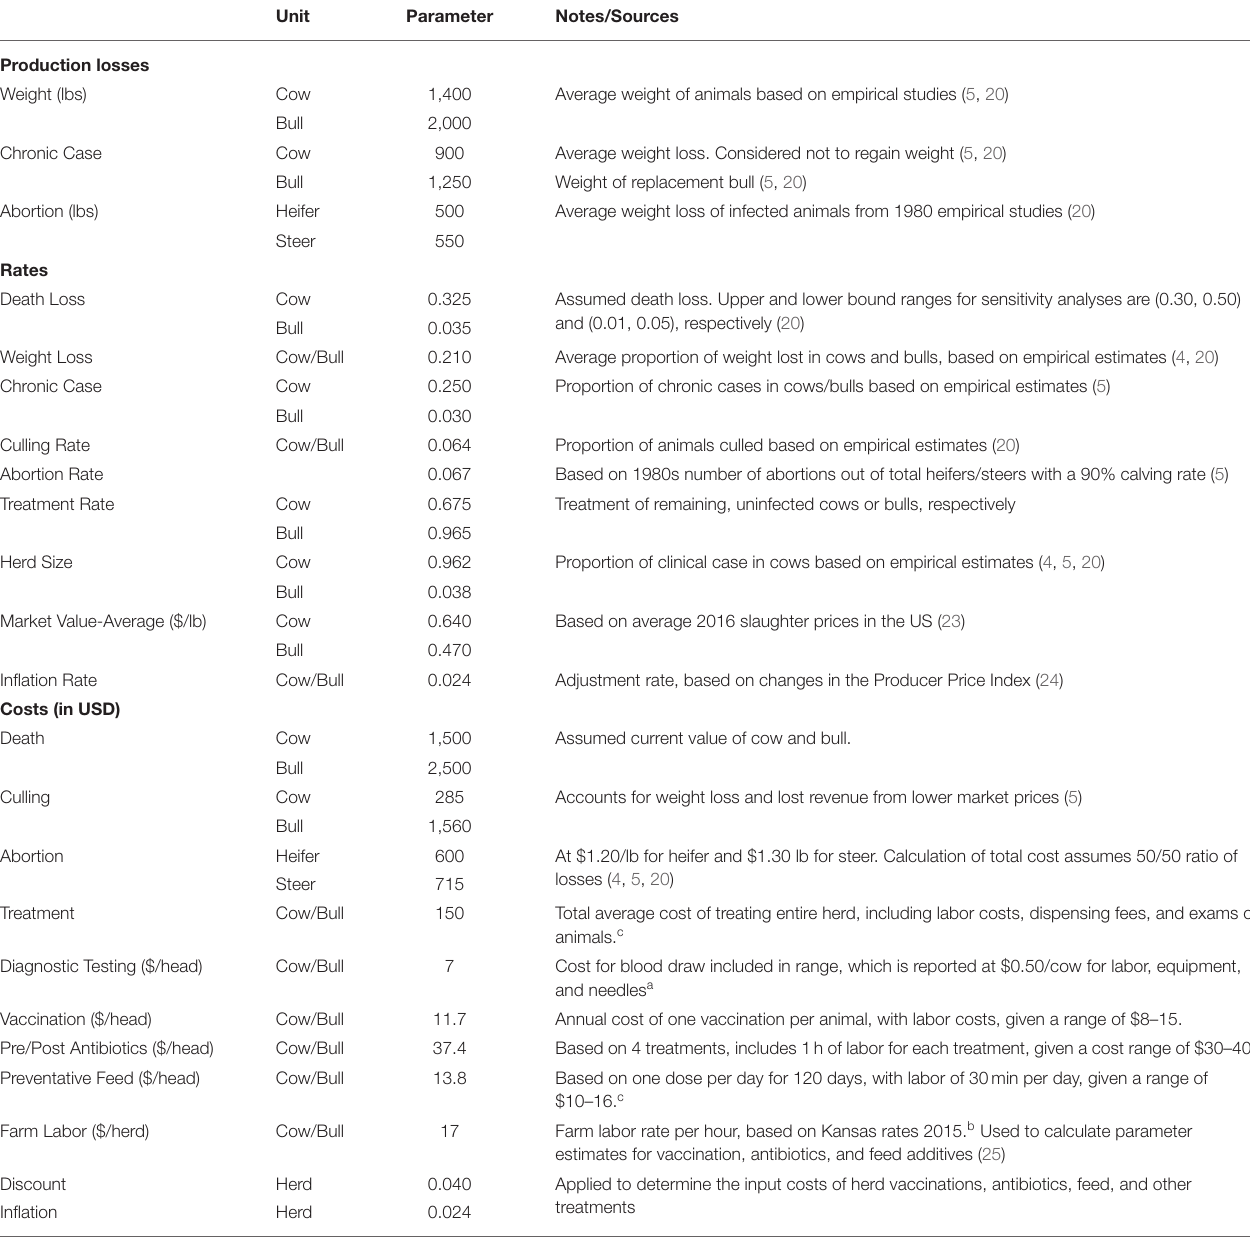
TABLE 1 | Parameters to calculate the expected cost of a clinical case of